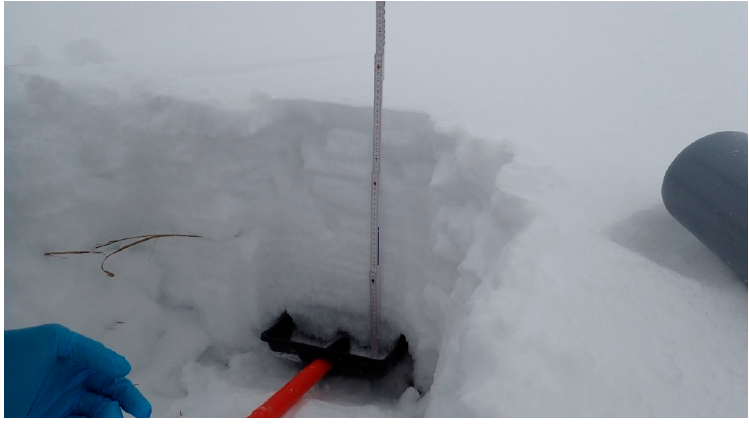
Figure 3. Sampling in snow pit at site 23. Photo was taken by O.S. Pokrovsky.